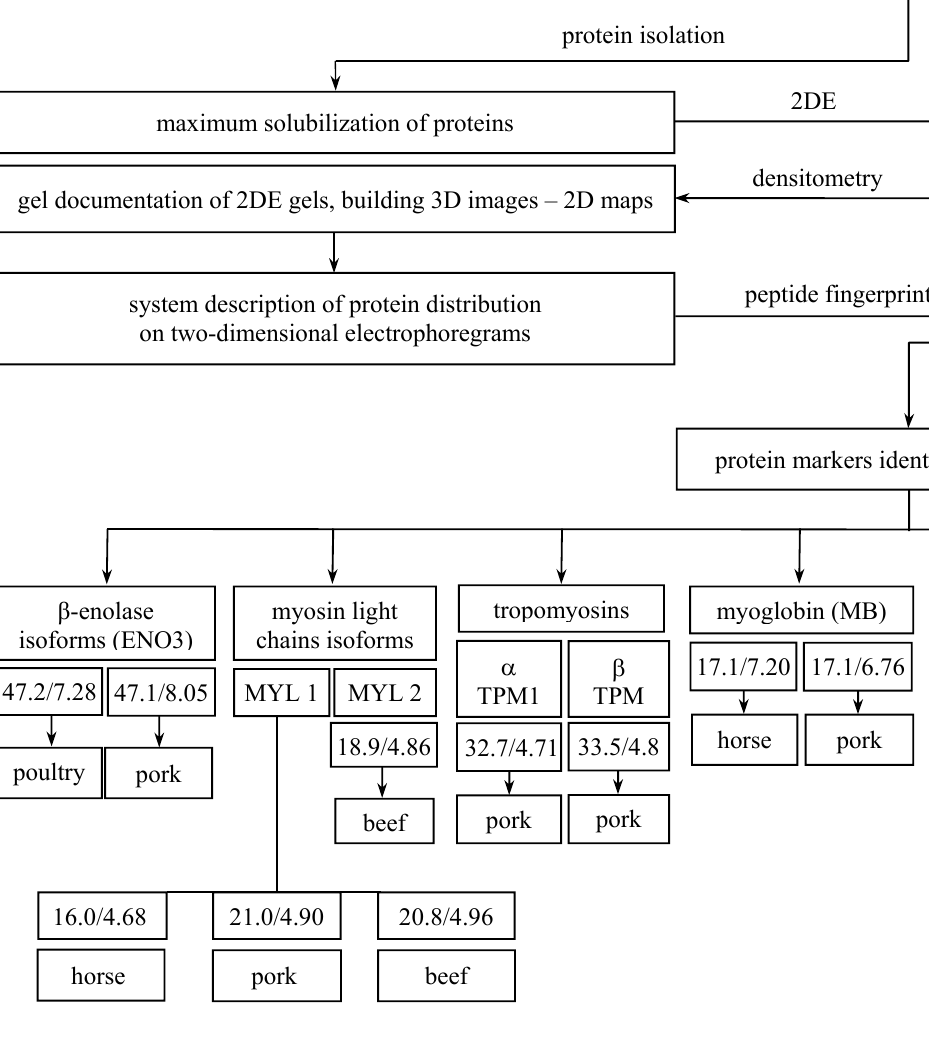
Fig. 7. Identification algorithm of species-specific proteins in raw materials of slaughter farm animals and